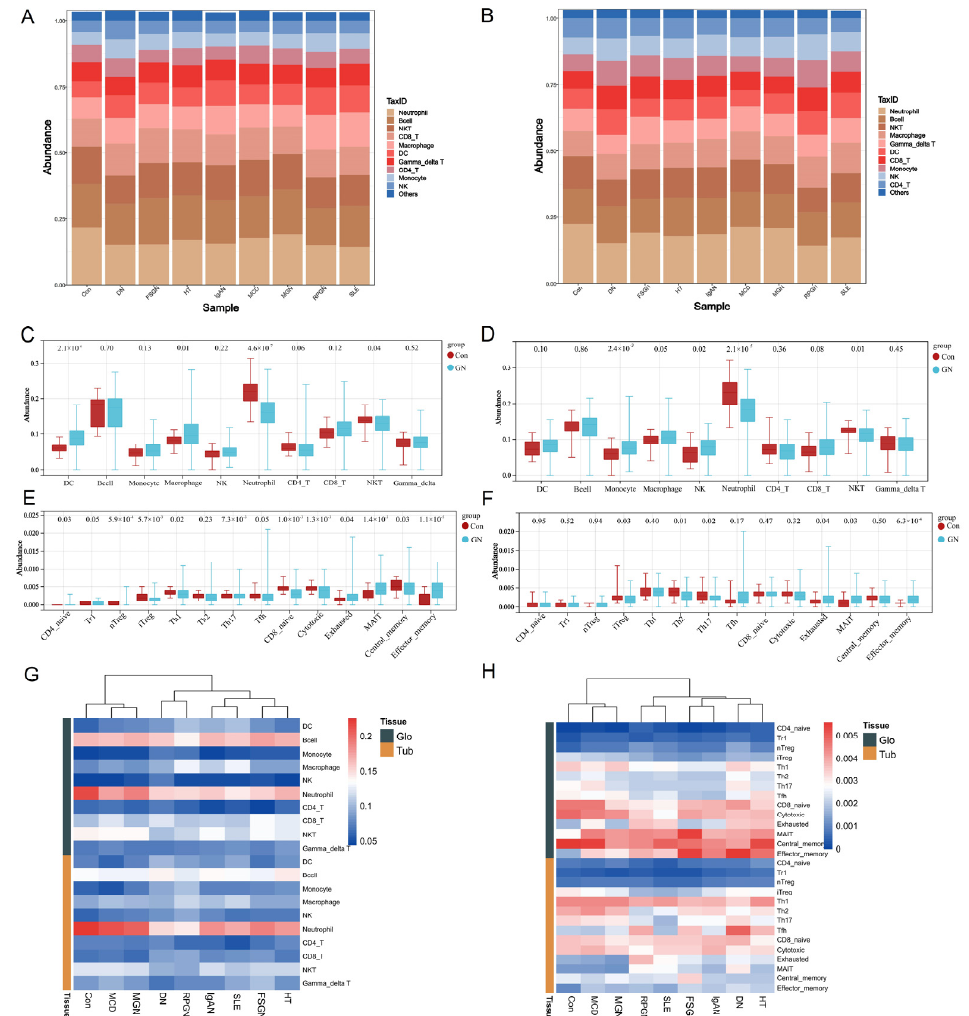
Figure 4. Immune signatures of the glomeruli and tubulointerstitium in GN. ( A ) Bar graph of 10 major types of immune cells in the glomeruli of 8 GN subtypes. ( B ) Bar graph of 10 major types of immune cells in the tubulointerstitium of 8 GN subtypes. ( C ) Boxplot of 10 major types of immune cells in the glomeruli of GN and healthy controls. ( D ) Boxplot of 10 major types of immune cells in the tubulointerstitium of GN and healthy controls. ( E ); Boxplot of 14 T-cell subtypes of immune cells